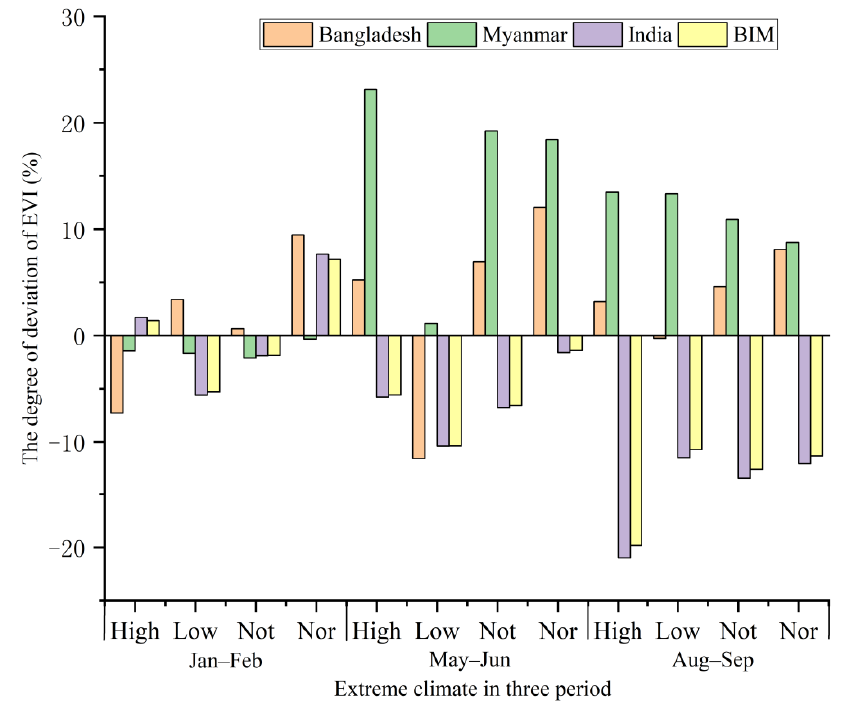
Figure 9. The degree of deviation of EVI under extreme climate in Bangladesh, India, Myanmar and South Asia (Abbreviations: High – Higher temperature and higher precipitation, Low – Higher temperature and lower precipitation, Not – Higher temperature without considering precipitation, Nor – Higher temperature and normal precipitation).